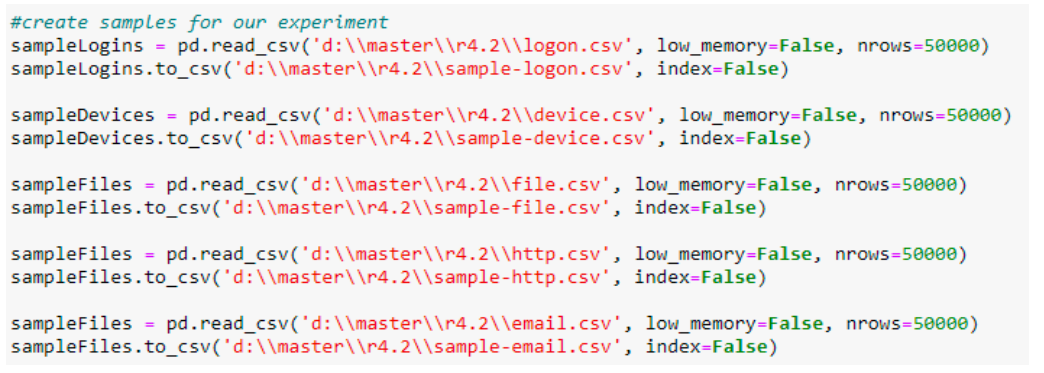
Figure 2. Create samples from the synthetic dataset.